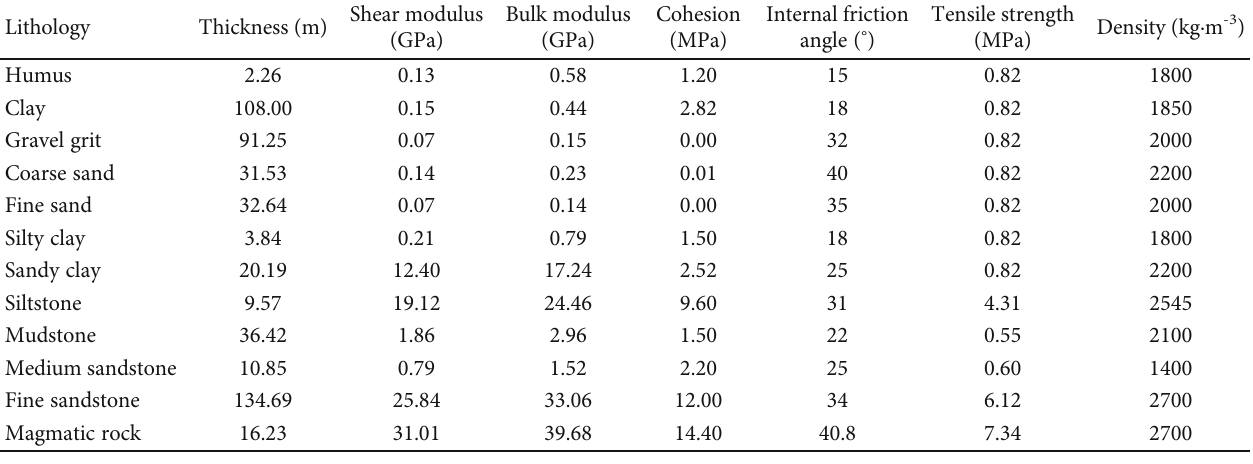
Table 5: Lithological physical and mechanical parameters.